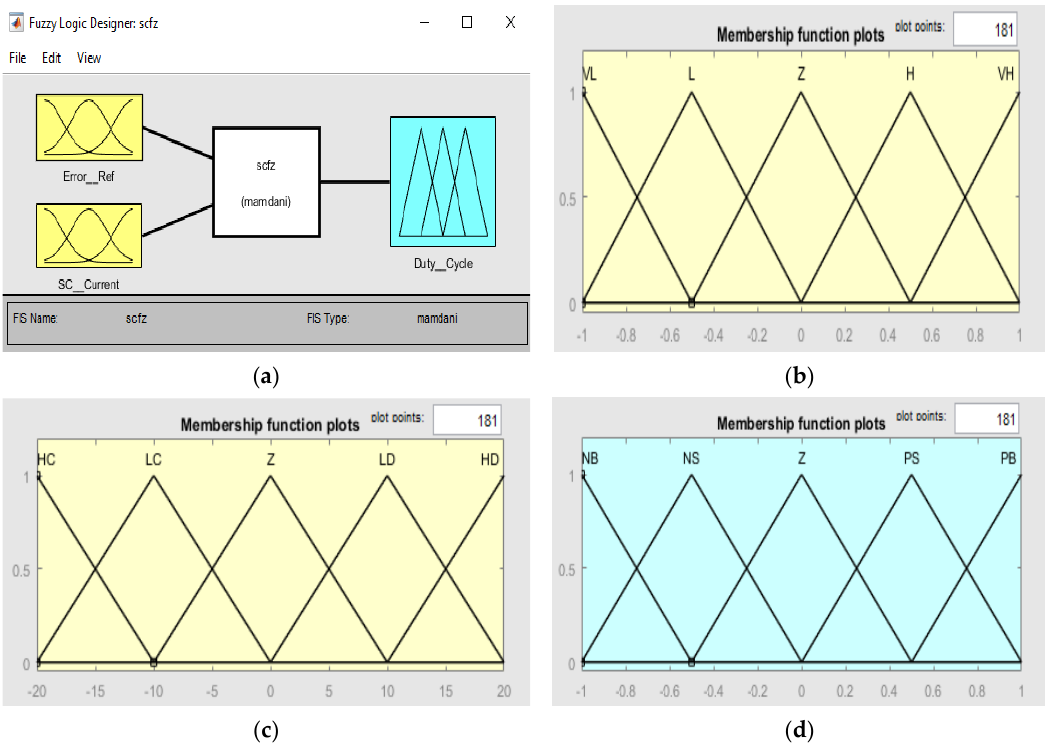
Figure 18. FLC of OSSC. ( a ) Fuzzy inference system for OSSC; ( b ) reference current; ( c ) OSSC current; and ( d ) duty cycle.